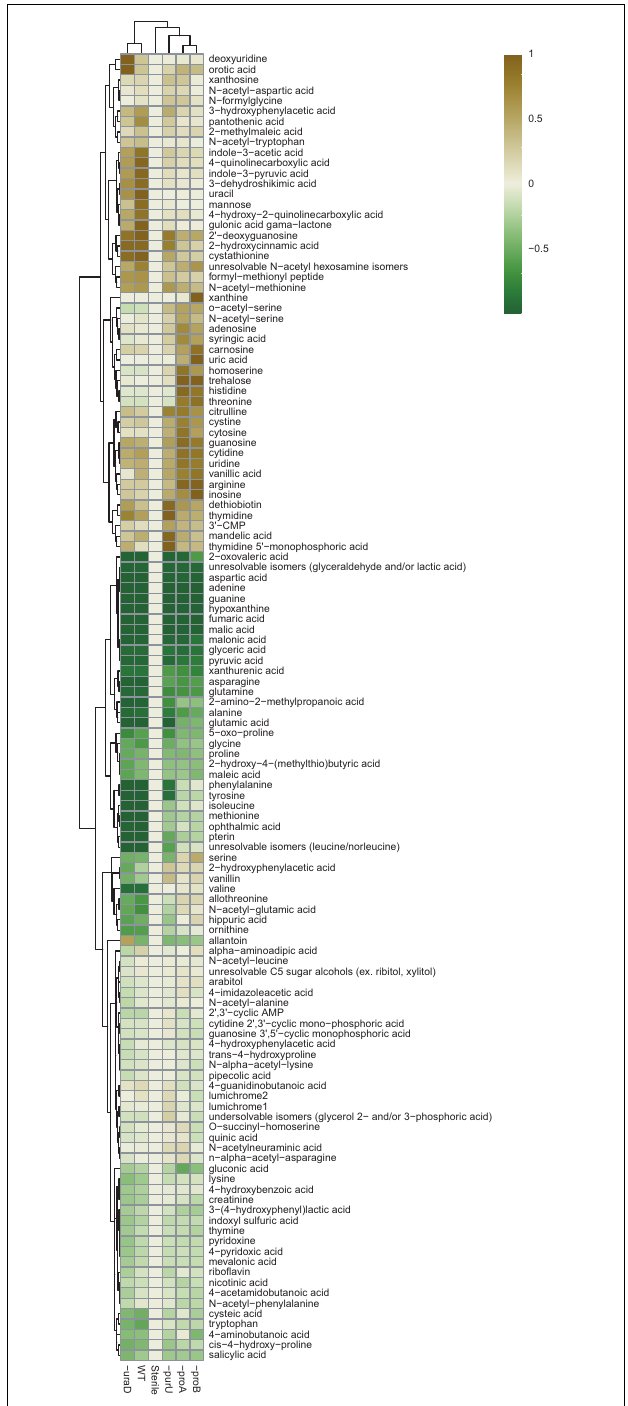
FIGURE 5 | Metabolomics. N1B4 spent medium was sterile filtered and used to culture Pseudomonas stutzeri RCH2 wild-type, and mutants (cid:49) uraD , (cid:49) purU , (cid:49) proA , (cid:49) proB for 24 h before collection of extracellular metabolites for extraction and LCMS analysis. A media control was incubated alongside the sample cultures to control for contamination and for comparison with starting metabolite abundances. A targeted analysis was performed using a library of m/z, retention time and MS2 spectra of common polar metabolites. Relative peak heights boxplots and statistical comparisons are available in Supplementary Figures 4 , 5 and Supplementary Table 6